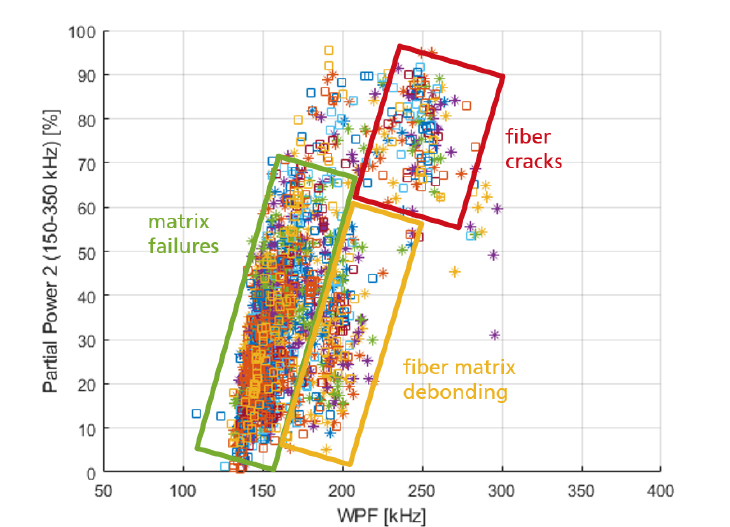
Figure 2. Partial Power 2 vs. Weighted Peak Frequency for all test specimens. Additionally, the clusters of damage mechanisms are shown. Asterisks: 0/90 specimens. Squares: +45/ − 45 specimens.